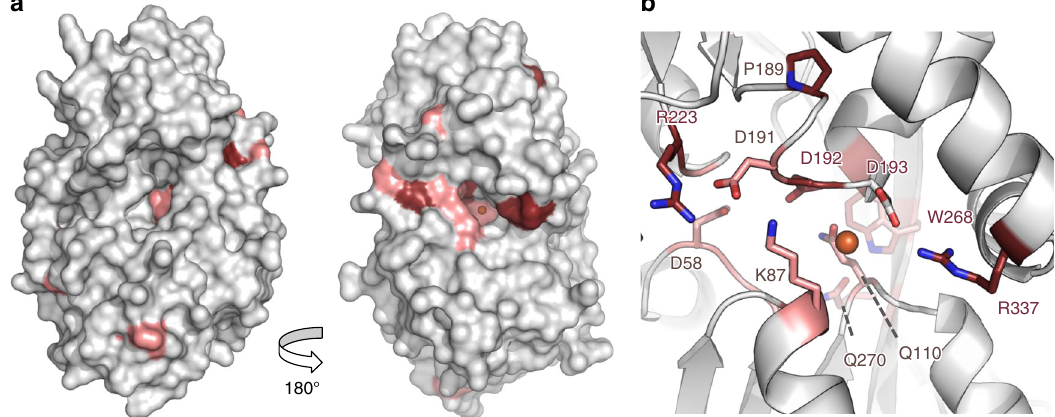
Fig. 6 IbpS unusual iron-binding site involves conserved residues. a Two different orientations of a surface representation of the iron-binding site of IbpS. Strictly conserved residues are colored in fi rebrick and strongly conserved (95%) residues are colored in salmon (see also Supplementary Fig. 8). Sequence conservation was obtained from the alignment of 122 sequences used to generate the phylogenic tree (Fig.1). b Detailed view of the metal binding site with side chains shown as ball-and-stick. Iron atom is depicted as an orange